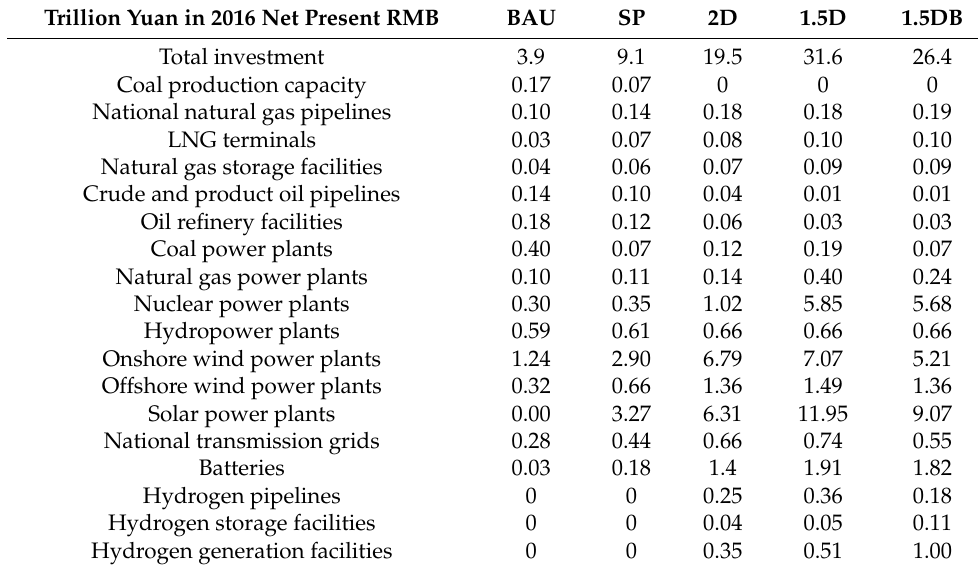
Table 4. Investment on national energy